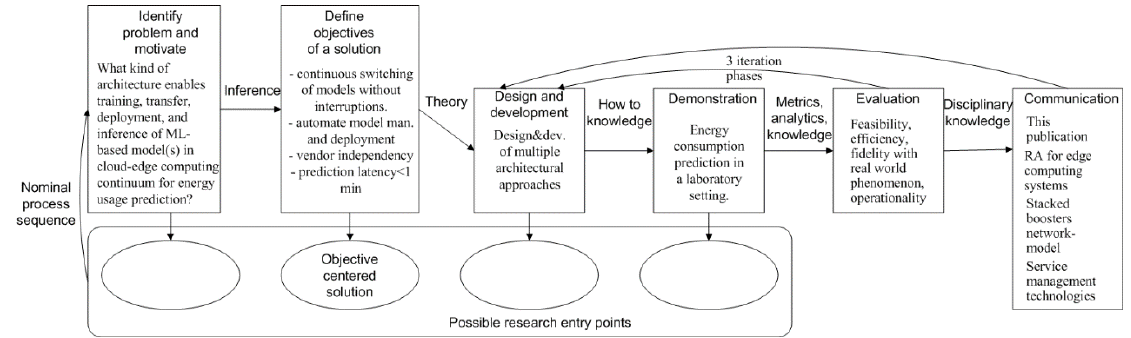
Figure 1. Our study was performed based on the Design Science Research Methodology